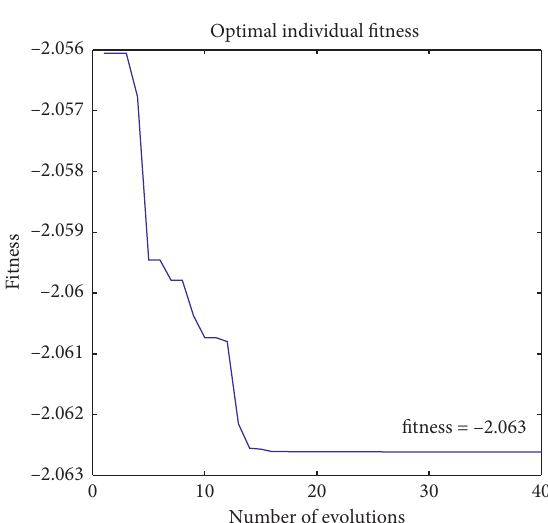
Figure 3: The search process for the optimal individual fitness.